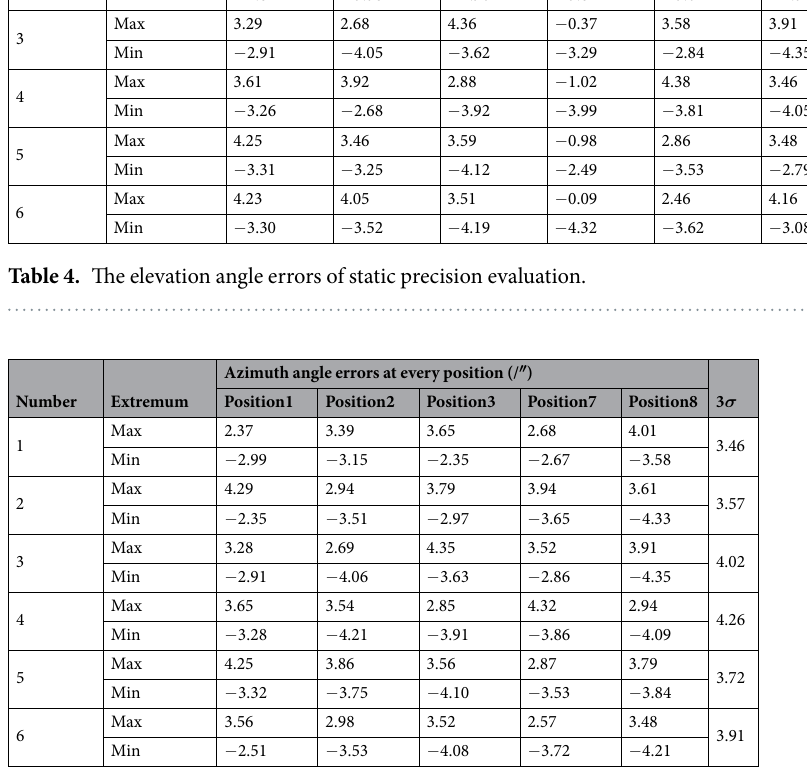
Using accurate starlight vector information provided by the star simulator as the gold-standard reference, the azimuth and the elevation errors of star sensor measurement are computed and provided in Tables 4 and 5. Tables 4 and 5 give the positive maximum and negative maximum of celestial angle errors at every position of every group experiment. It can be seen that the azimuth and the elevation errors have good consistency and sta- bility. The 3-standard-deviation values (3 σ ) of the celestial angle errors are calculated using all data of all observa- tion positions in every group experiment. There are 50 points at every position. The 3 σ values of elevation errors in 6 groups of experiments are 3.32 ″ , 3.58 ″ , 4.06 ″ , 4.23 ″ , 3.69 ″ , and 3.83 ″ , and the 3 σ values of azimuth errors in 6 groups of experiments are 3.46 ″ , 3.57 ″ , 4.02 ″ , 4.26 ″ , 3.72 ″ , and 3.91 ″ . Based on the experimental results, it is